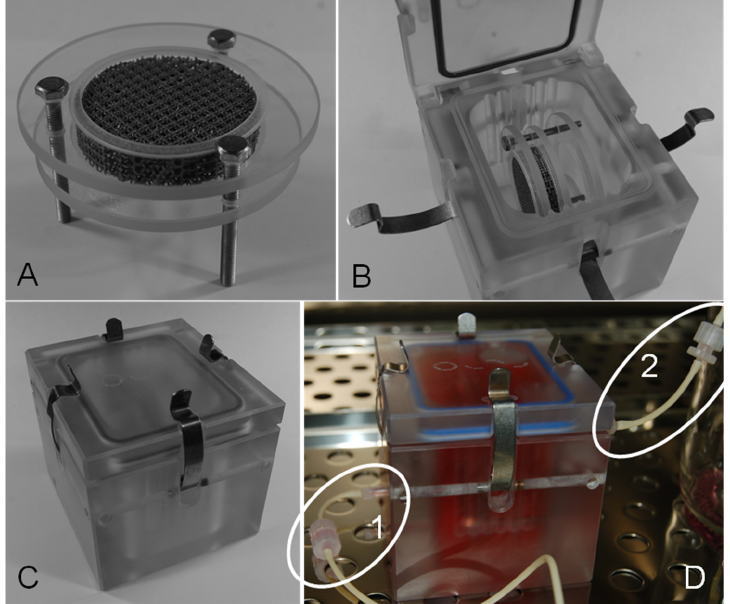
Figure 3. Scaffold placement. ( A ) Titanium scaffold fixed in polycarbonate disks; scaffold placed in the closed per(i)fusion system. 1D—medium influx. 2D—medium